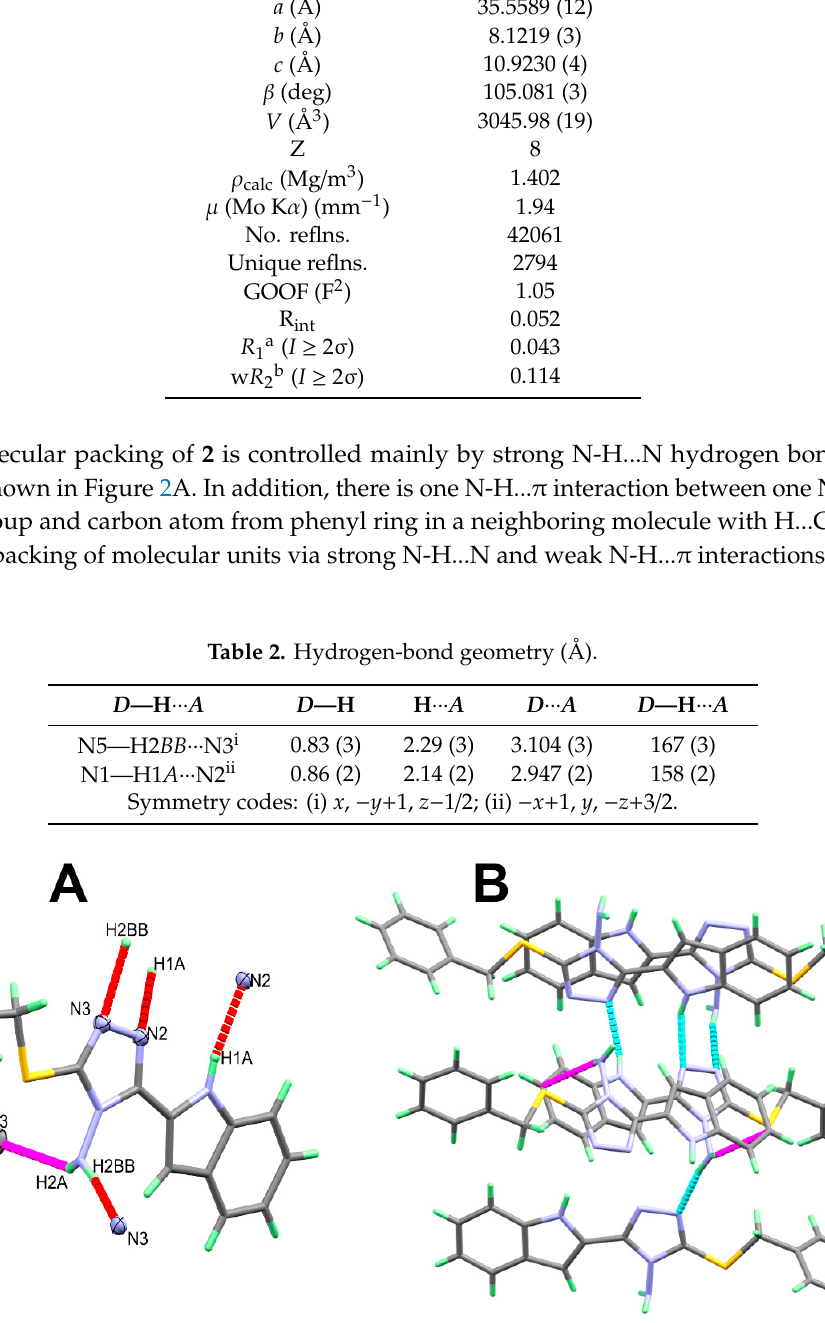
Figure 2. Intermolecular contacts ( A ) and packing ( B ) of molecular units in 2 . For clarity, the N-H... π interactions are labelled in magenta dotted